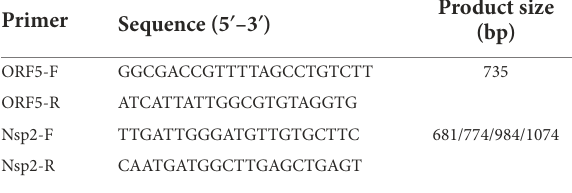
TABLE 1 Primers used for Porcine reproductive and respiratory syndrome virus (PRRSV) detection in this study. Primer